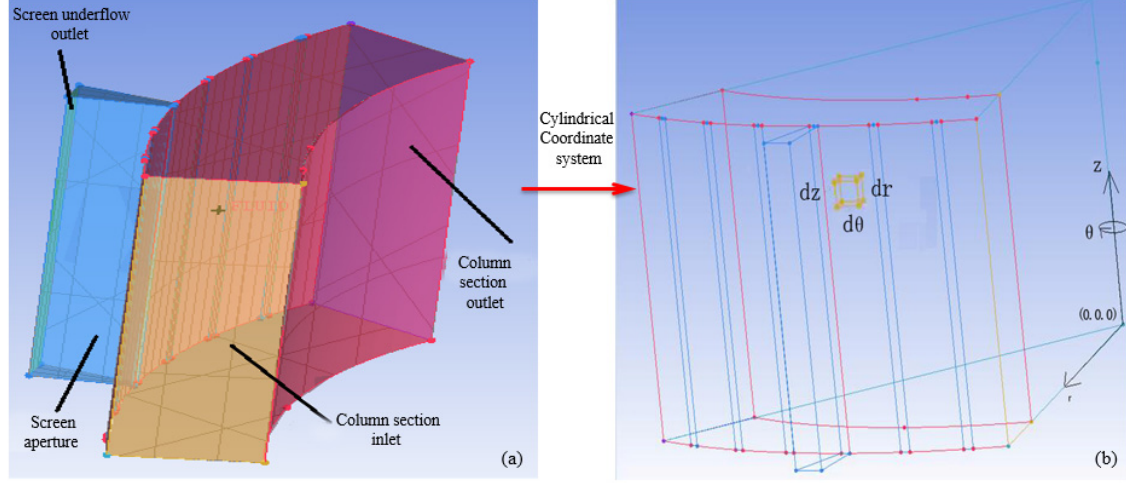
Figure 2. Fluid passing through single aperture ( a ) simple model and ( b ) cylindrical coordinate system. Table 1. Structure parameters of abstract fan models for TPHS.